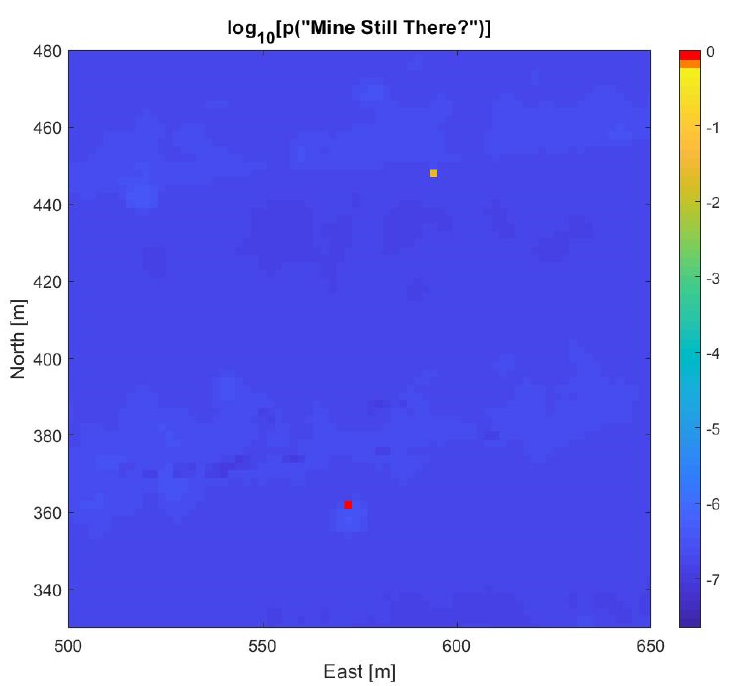
Figure 8. A 150 m × 150 m zoom view of Figure 7, covering two of the identified contacts, which are visible as single cells with significantly higher mine probabilities than the background. The red cell corresponds to an identified mine (M) and the yellow cell to a NOMBO (O).